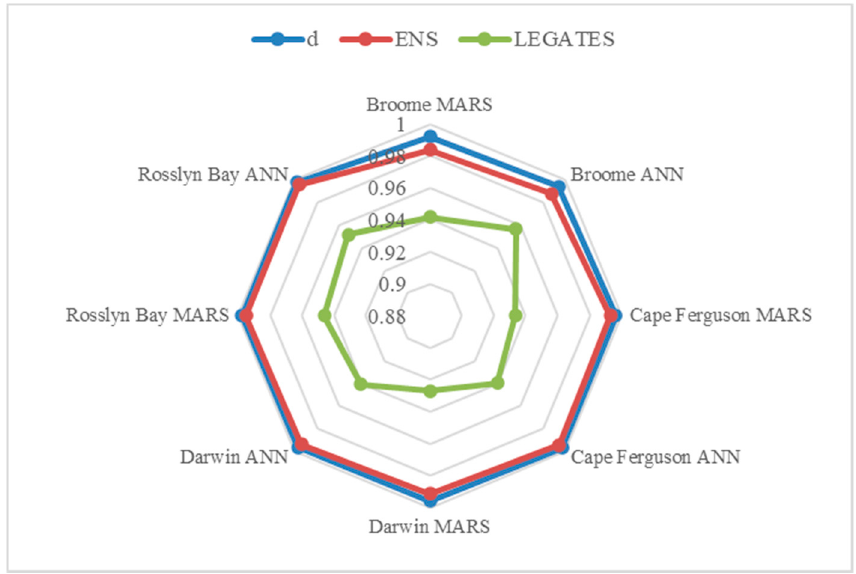
Figure 7. Radar the absolute prediction error distribution of MARS and ANN